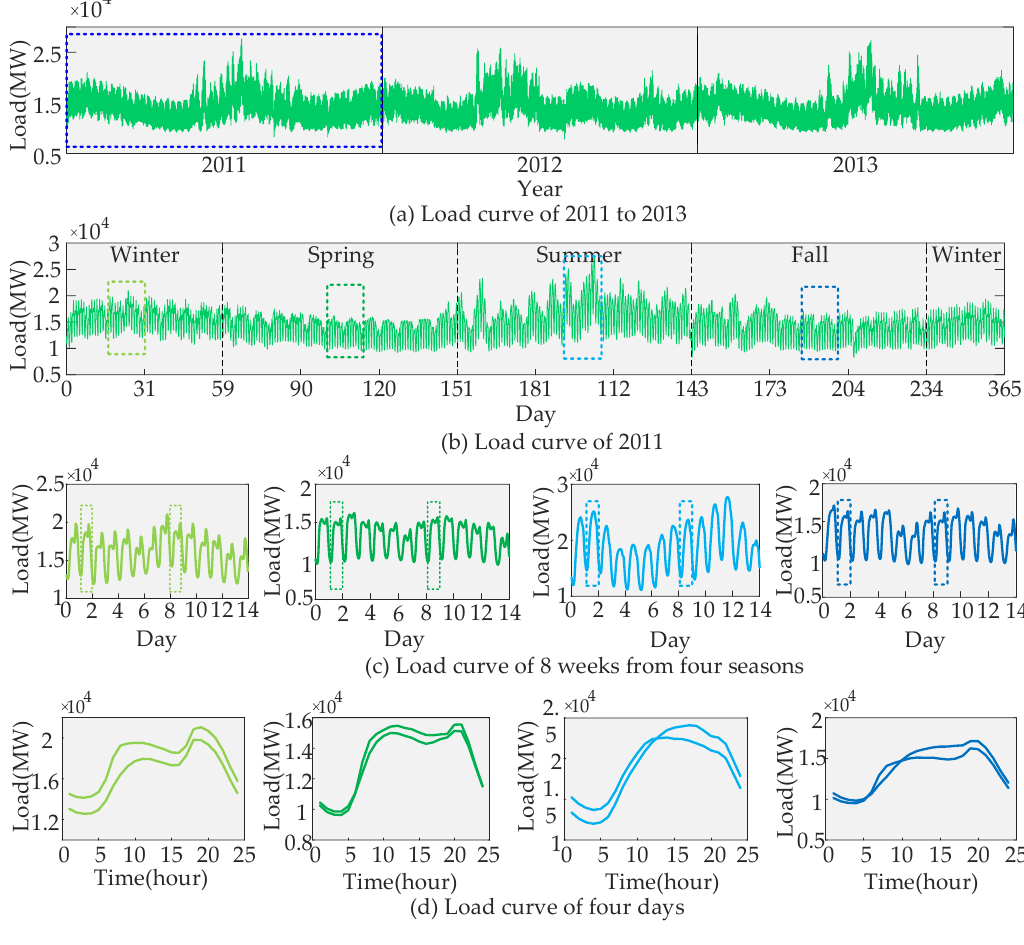
Figure 1. The power load of New England.